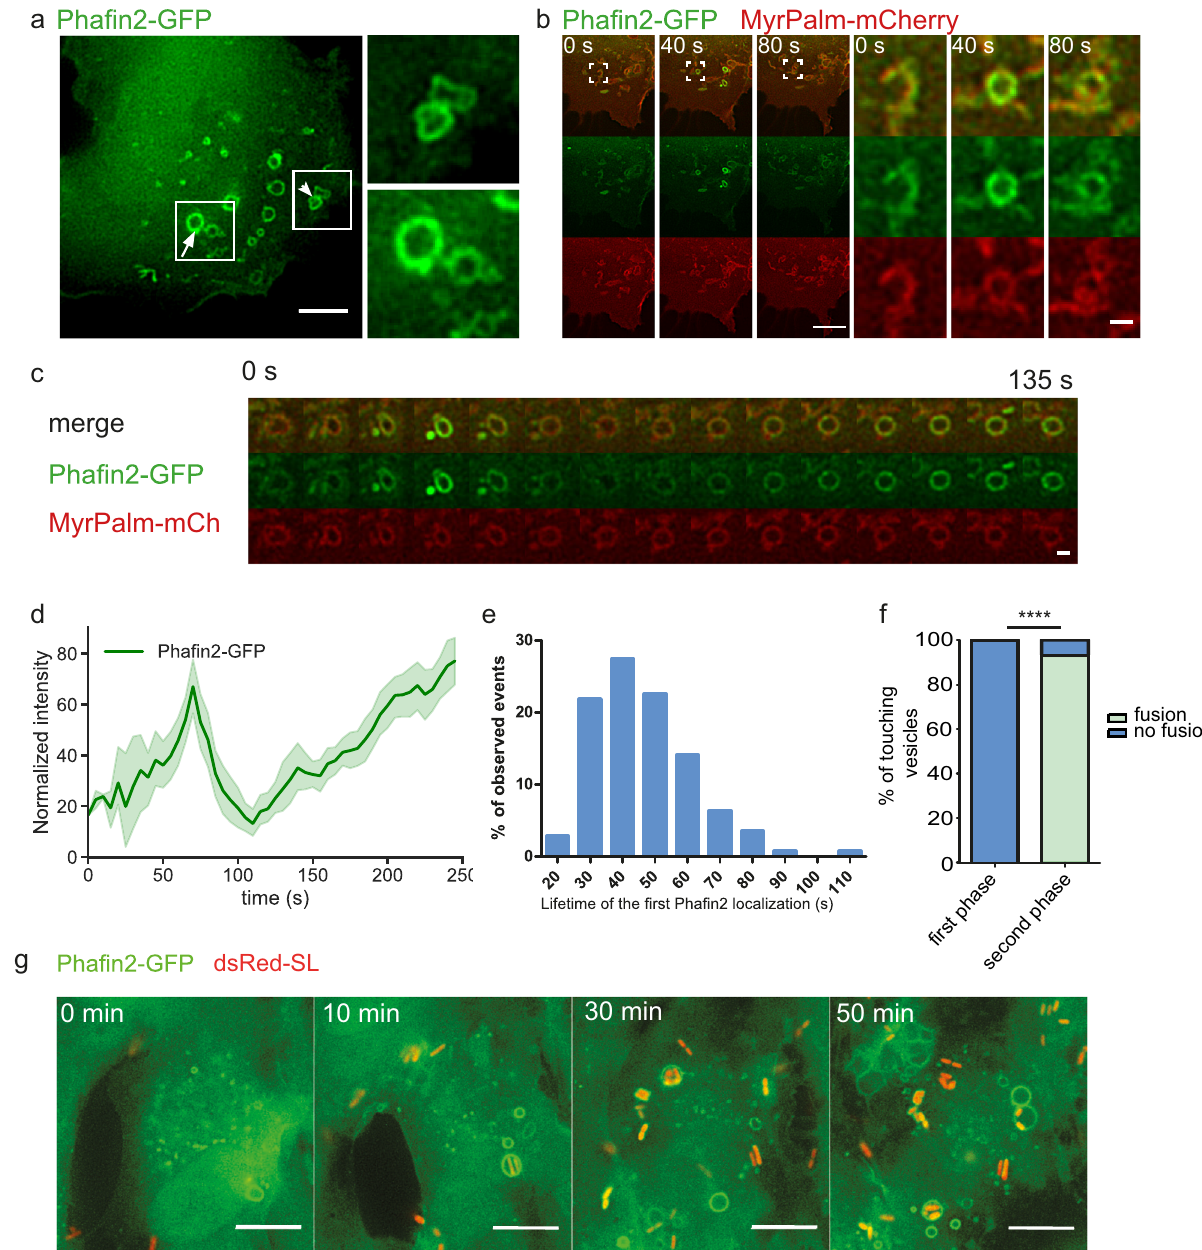
Fig. 1 Pha fi n2 shows biphasic recruitment to nascent and early macropinosomes. a Micrograph of RPE1 cells expressing Pha fi n2 showing labeling on two different vesicle classes - round, endosome-like vesicles within the cell (arrow) and non-uniformly shaped structures close to the cell periphery (arrowhead). Scale bar: 10 µ m. Representative image for n = 10 cells. b Cells co-expressing Pha fi n2-GFP and MyrPalm-mCherry. Pha fi n2 transiently localizes to macropinosomes forming from membrane ruf fl es. Shown are three frames from a time-lapse sequence, spaced 40 s apart. Representative image for n = 40 cells. Scale bar: 5 µ m, scale bar inset: 1 µ m. c Sequential images showing Pha fi n2-GFP dynamics on newly formed macropinosomes; images were acquired every 5 s. Representative image for n = 25 macropinosomes. Scale bar: 1 µ m. d Tracking of individual macropinosomes shows a biphasic Pha fi n2 localization to macropinosomes. All tracks were temporally aligned to the fi rst peak of Pha fi n2 fl uorescence. n = 25 macropinosomes, mean + 95% CI e Histogram showing the average life-time of the fi rst Pha fi n2 localization. n = 142 macropinosomes. f Macropinosomes labeled with the fi rst Pha fi n2 localization are fusion incompetent, whereas vesicles readily undergo fusion during the second phase of localization. n = 53 macropinosomes. Two-sided Fisher ’ s exact test, p < 0.0001. g Pha fi n2 localizes to Salmonella -induced macropinosomes and Salmonella -containing vacuoles in RPE1 cells. Representative image for 30 cells. Scale bar: 10 µ m. Statistics source data for d , e , and f are provided in this was highly selective for PtdIns3P 17 (Fig. 3b). We did not observe was still recruited to endosomes and macropinosomes, but the fi rst transient localization to newly formed macropinosomes binding to any other phosphoinositide species. We generated Pha fi n2 constructs bearing point mutations that abolish lipid- (Fig. 3c, d, Supplementary Movie S3) was abolished, while binding activity in the PH (R53C) 18 and FYVE (R176A) 19 Pha fi n2(R176A) completely lost all membrane association (Fig. 3e, domains and assessed their localization behavior. Pha fi n2(R53C) f, Supplementary Movie S4). Thus, PtdIns3P binding by the